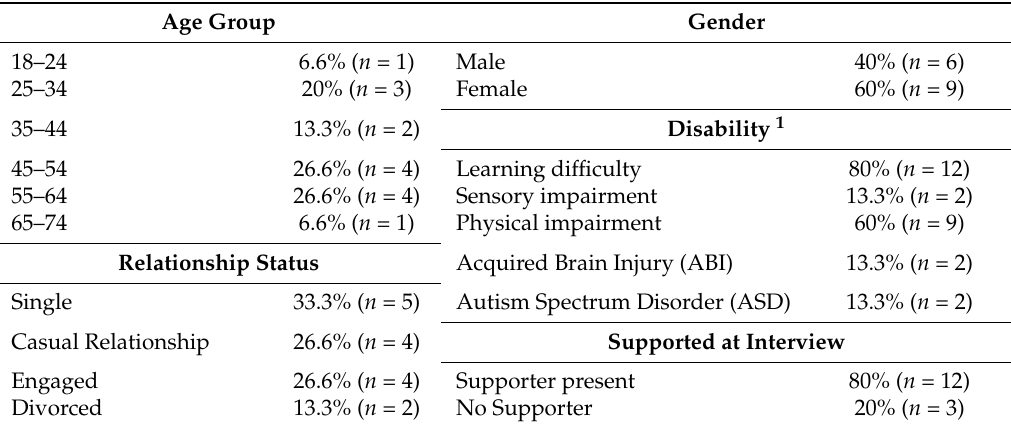
Table 1. Demographics: Disabled